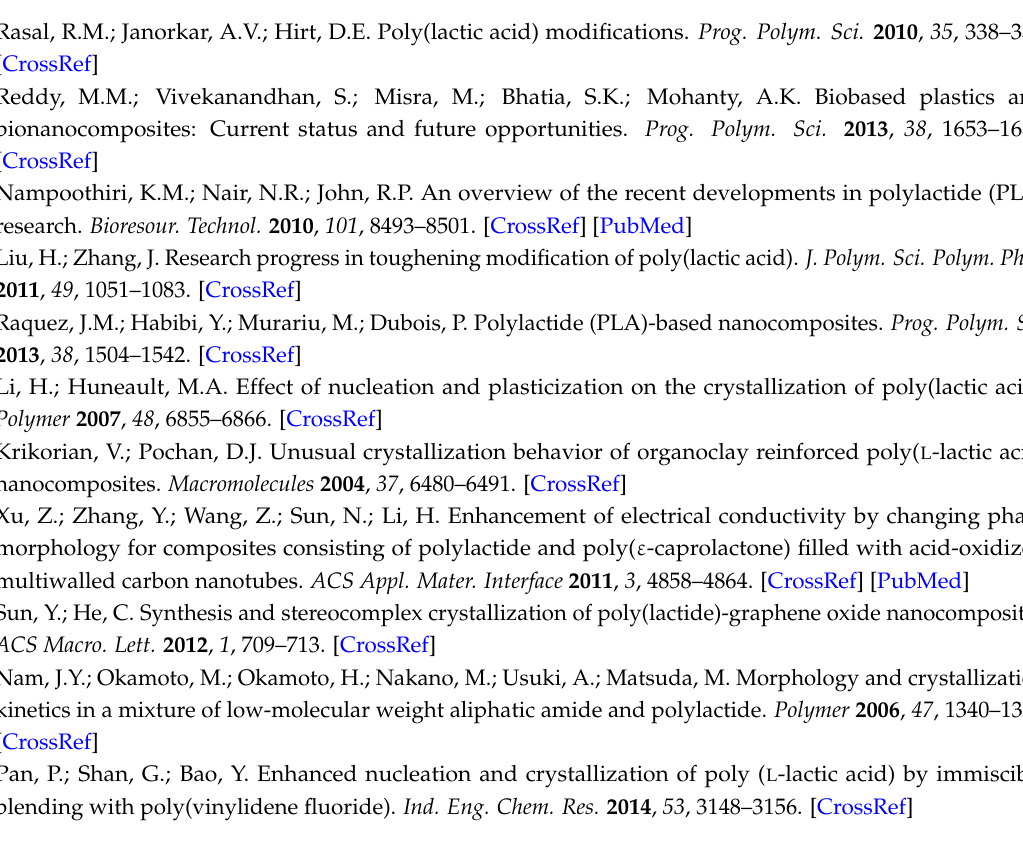
Figure S1: The chemical structure of the OXA, Figure S2: DSC heat flow as a function of isothermal crystallization time and temperatures for the PLLA/OXA (100/0.5 wt / wt ) samples, Figure S3: First heating DSC curves of the sheared PLLA/OXA-240 samples after the rheological experiments at 155 ◦ C, Table S1: Thermal parameters of the PLLA and PLLA/OXA samples obtained from the DSC cooling and 2nd heating scans, Table S2: Thermal parameters of the PLLA/OXA-240 samples derived from Figure